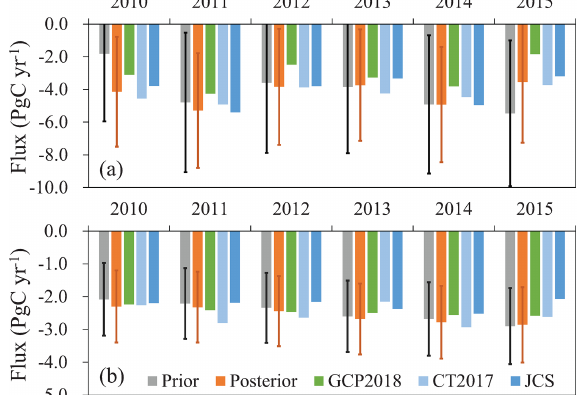
Figure 8. Interannual variations in global (a) BIO and (b) OCN fluxes of the prior and posterior as well as GCP2018, CT2017, and Jena CarboScope